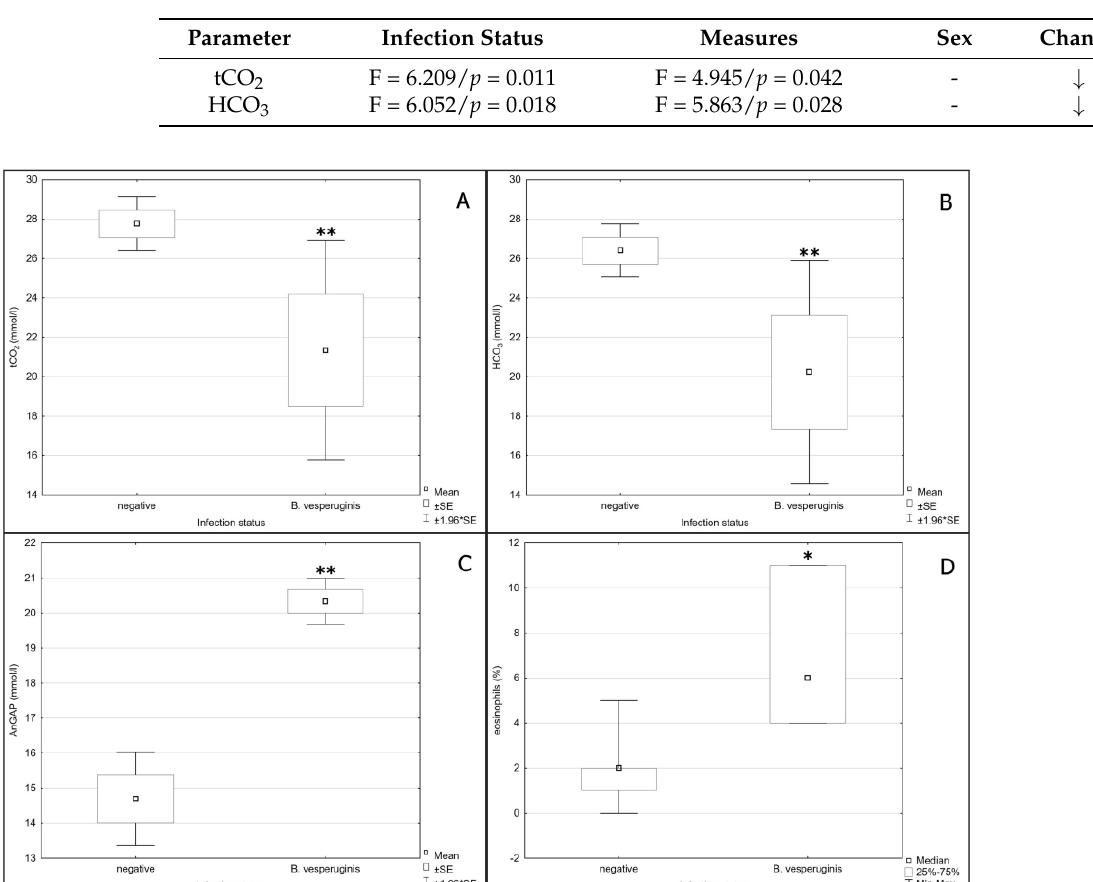
Table 3. Repeated Measures ANOVA in parameters influenced by infection status.